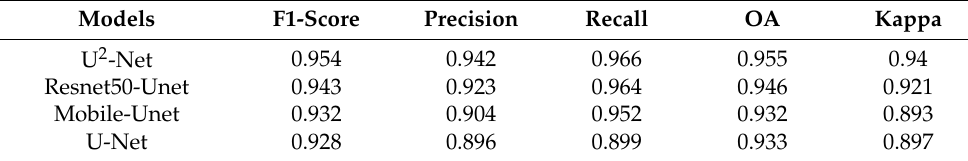
Table 4. The coniferous forest extraction accuracy of the deep learning